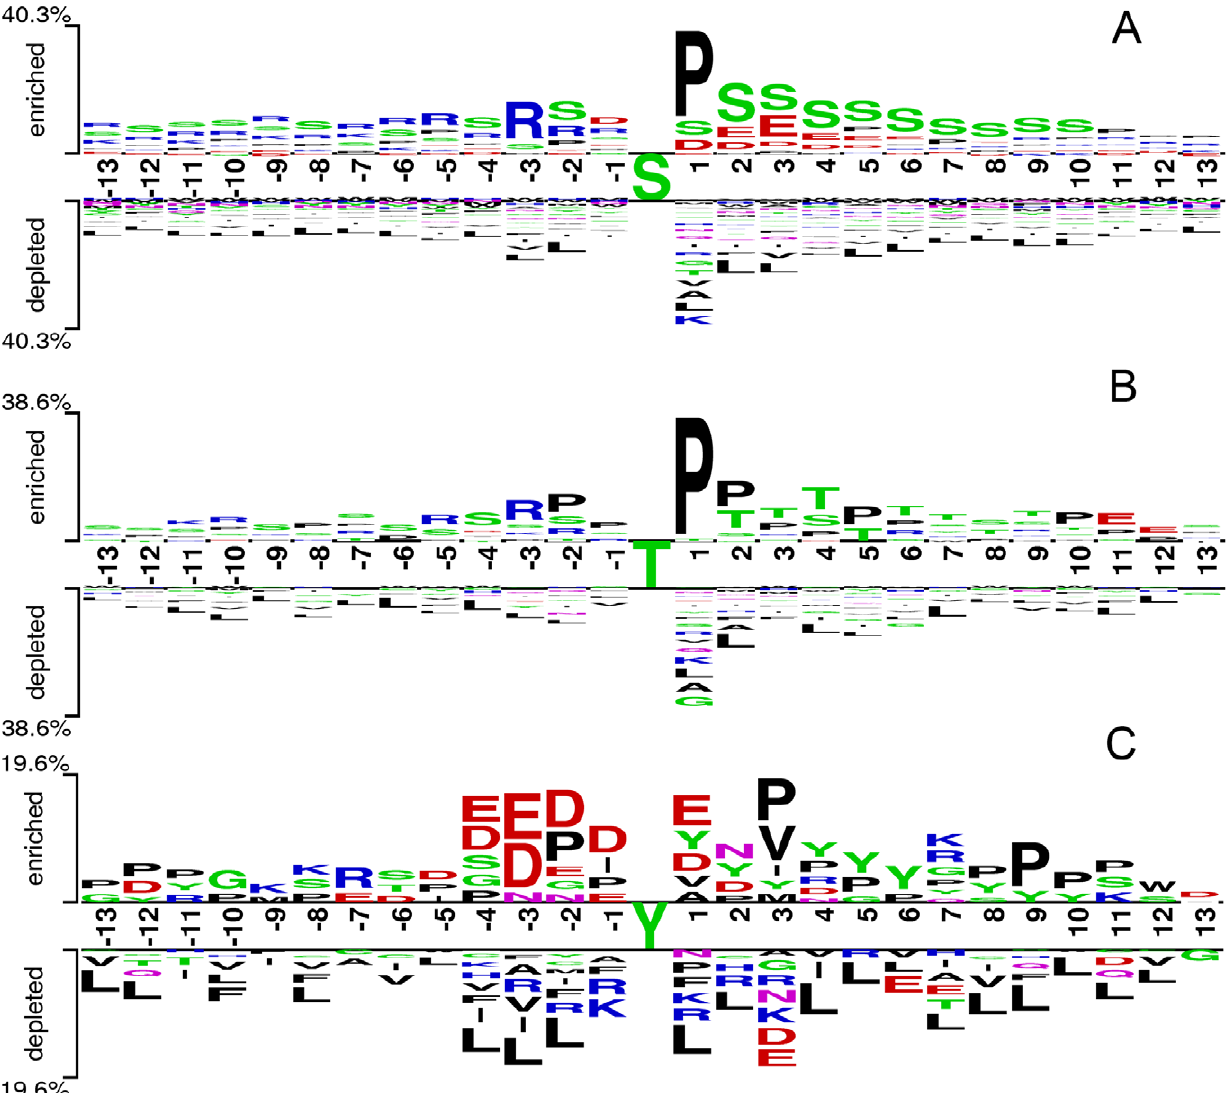
Figure 4. Three Two-Sample-Logos of the position-specific residue composition surrounding the phosphorylated site and non- phosphorylated sites. (A) serine site logo, (B) threonine site logo, (C) tyrosine site logo. These three logos were generated using the web server http://www.twosamplelogo.org/ and only residues significantly enriched and depleted surrounding phosphorylated sites ( t -test, P , 0.05) are shown. a neural network-based method for predicting potential phos-